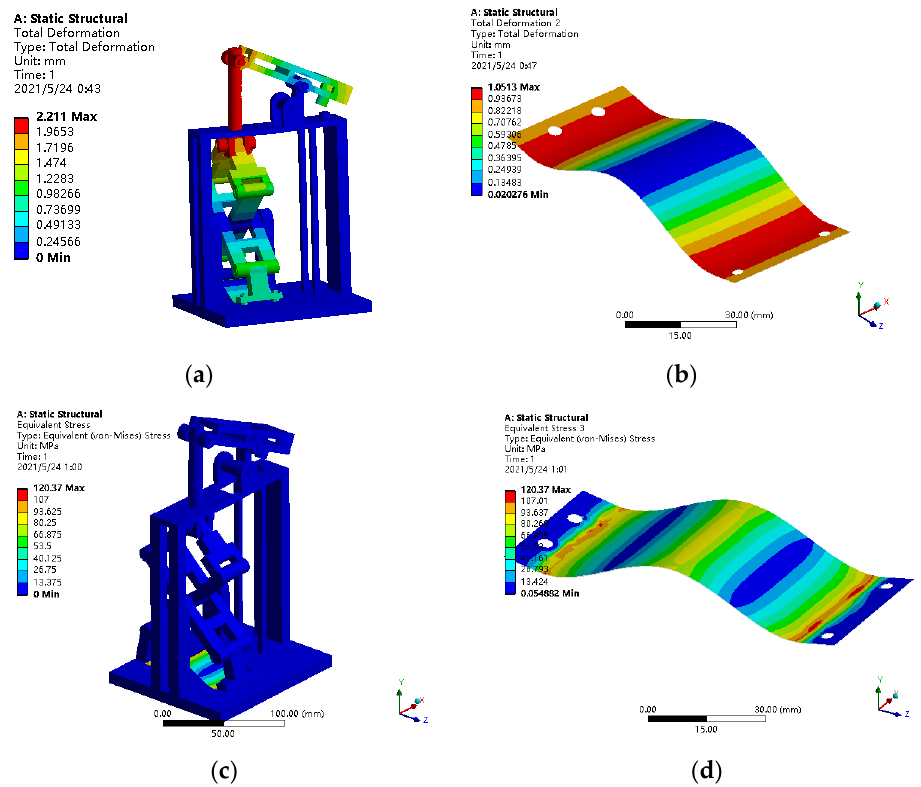
Figure 7. Deformation and stress of piezoelectric generator under external excitation. ( a ) Overall deformation; ( b ) elastic steel plate deformation; ( c ) overall stress; ( d ) elastic steel plate stress.